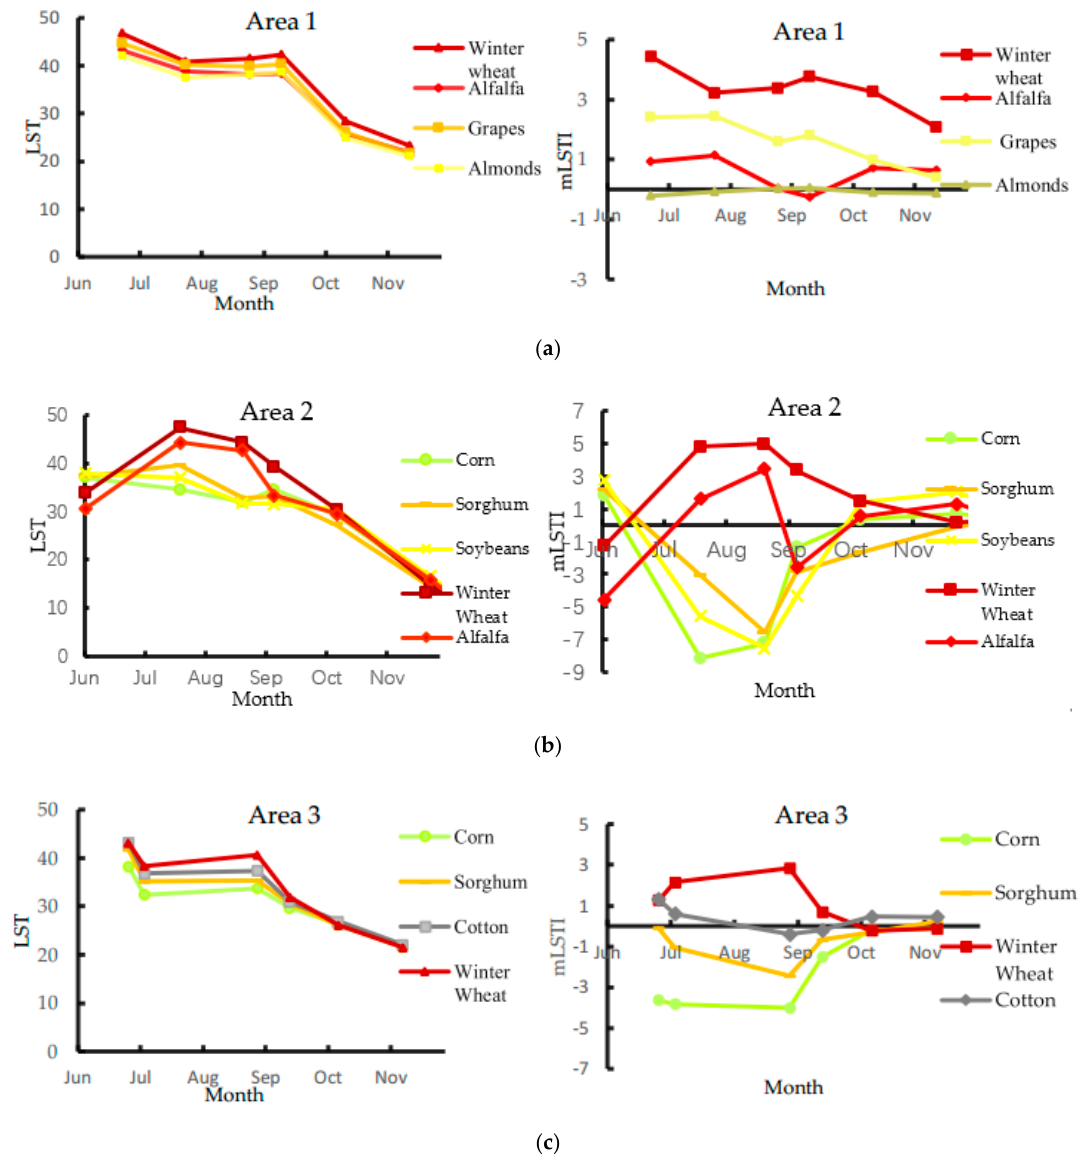
Figure 4. The land surface temperature (LST) and the modified land surface temperature index (mLSTI) curves of ( a ) study area 1, ( b ) study area 2, and ( c ) study area 3.